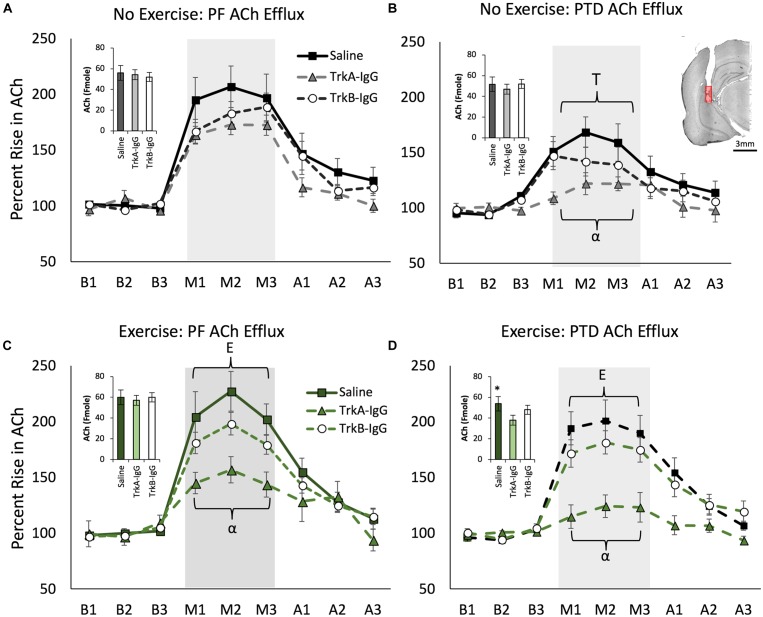
Hippocampal acetylcholine (ACh) efflux measured throughout baseline (B1–B3), spontaneous alternation (M1–M3) and post-baseline (A1–A3) phases. Inset graphs represent basal ACh levels in femtomoles. PTD-treatment reduced ACh efflux during maze testing (A) vs. (B). In the no exercise condition (Stat), sequestering NGF with TrkA IgG reduced ACh efflux during maze testing in PTD rats (B). Exercise increased ACh efflux in both PF control and PTD-rats (C,D). In PTD VEx rats (D), exercise rescued the impaired ACh levels to the level of control rats. However, sequestering NGF suppressed behaviorally activated ACh efflux from exercise in both PF and PTD rats (C,D). E indicates a significant effect of exercise; T indicates a significant effect of treatment, ∗ indicates a significant effect of TrkA-IgG microbeads on basal ACh and α indicates a significant effect of blocking NGF. Within (B) is an illustrative example hippocampal placement of the microdialysis cannula. The red region represents the probe membrane.